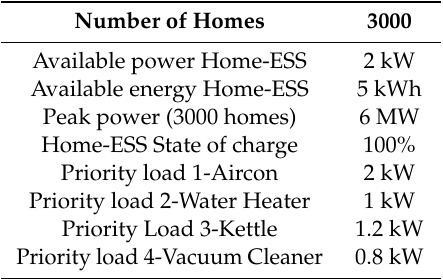
Table 2. Aggregation of HESS and Voluntary Demand Management